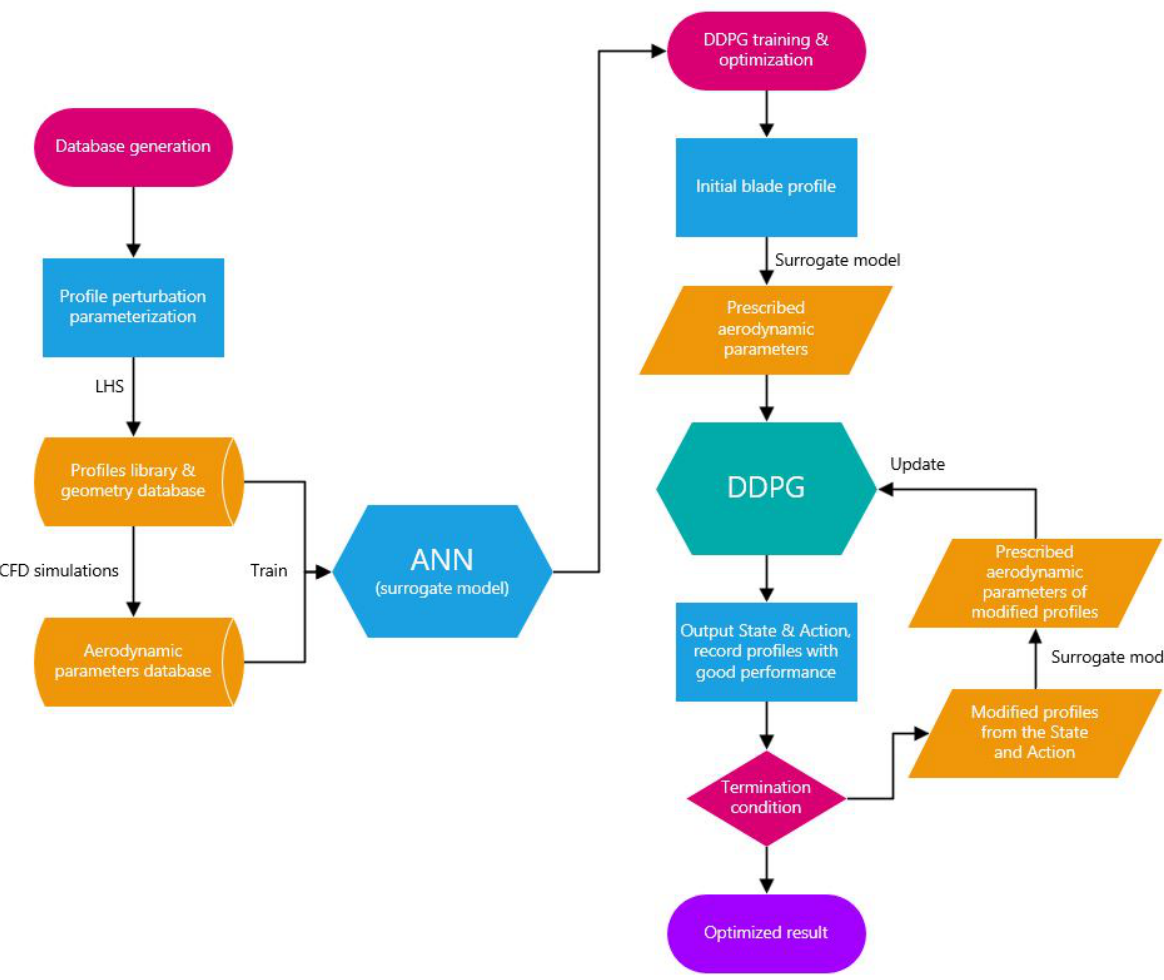
Figure 1. Flowchart of multi-objective optimization of cascade blade